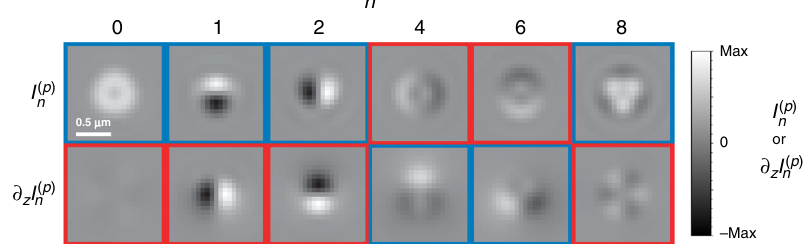
Fig. 2 Theoretical PSF components in CHIDO imaging. The fi gure shows both I ð p Þ n and ∂ z I ð p Þ n for c = π , z = 0, and p ¼ R . The corresponding components for p ¼ L are identical, except that those surrounded by red boxes would have the opposite sign. Each row is normalized separately as their units are different.